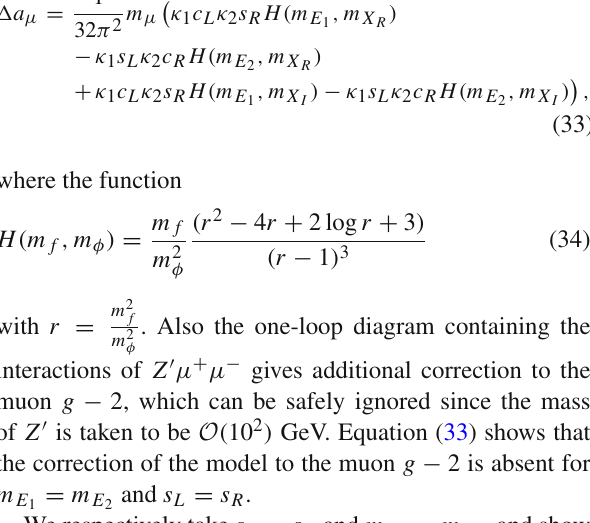
s L = s R = 0, both (cid:15) NP the corrections to T parameter are also absent. The case of s L = s R = 0 is disfavored by the CDF measurement of W